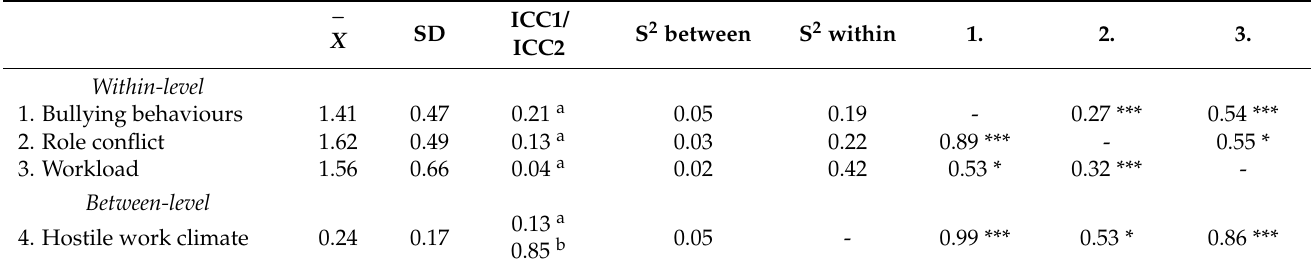
Table 1. Mean, standard deviation, ICC, and within- and between-level correlations for all study variables (N = 1290 participants, N = 108